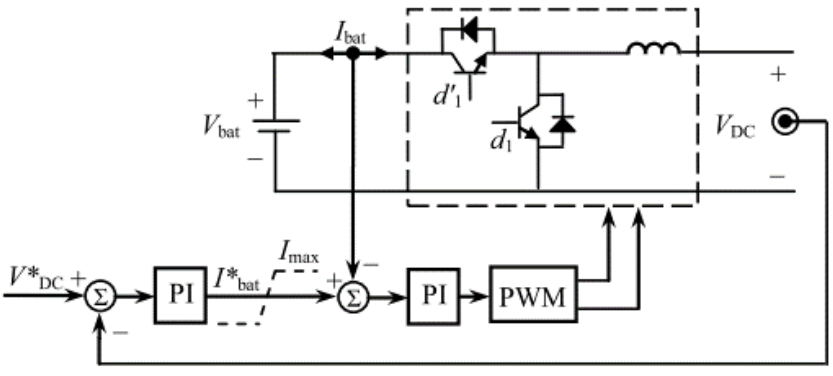
Figure 11. Control structure of bi-directional DC/DC